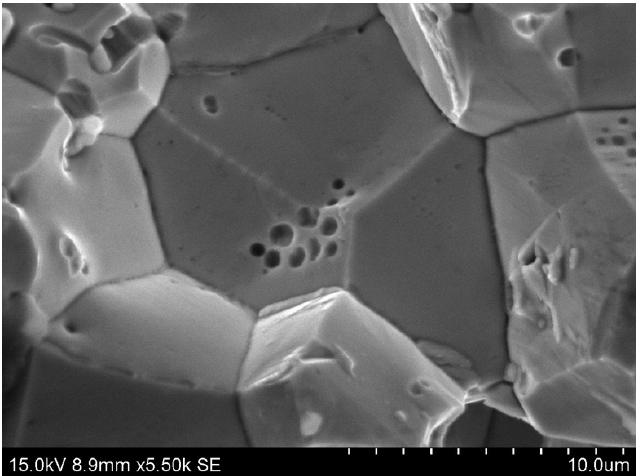
Figure 14. Fracture surfaces of sintered molybdenum powder at 1450 ◦ C under 70 MPa during 30 min without reduction stage at 650 ◦ C, showing the e ff ect of gaseous